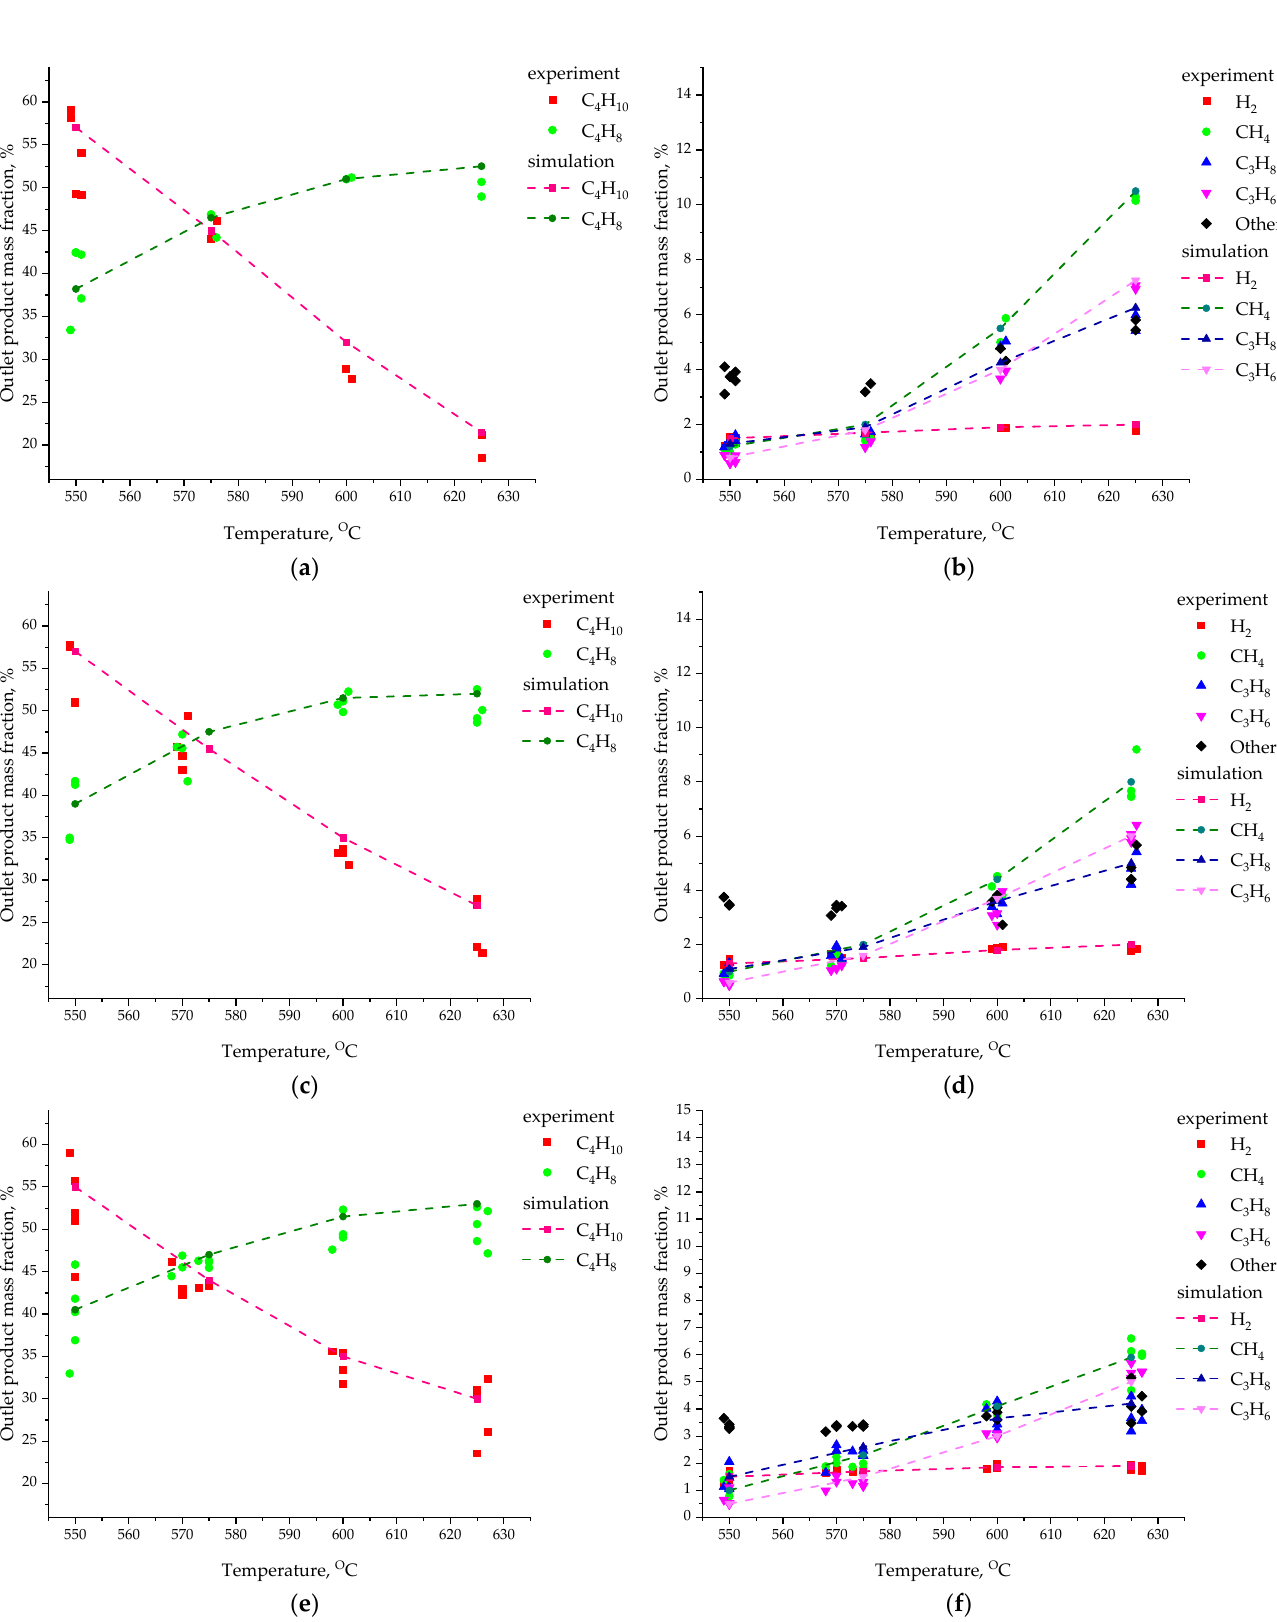
Figure 8. The mass fraction of reaction products for the case of catalyst mass of 100 g: ( a ) C 4 H 10 and C 4 H 8 at v = 0.008 m/s; ( b ) H 2 , CH 4 , C 3 H 8 , C 3 H 6 at v = 0.008 m/s; ( c ) C 4 H 10 and C 4 H 8 at v = 0.012 m/s; ( d ) H 2 , CH 4 , C 3 H 8 , C 3 H 6 at v = 0.012 m/s; ( e ) C 4 H 10 and C 4 H 8 at v = 0.016 m/s; and ( f ) H 2 , CH 4 , C 3 H 8 , C 3 H 6 at v = 0.016